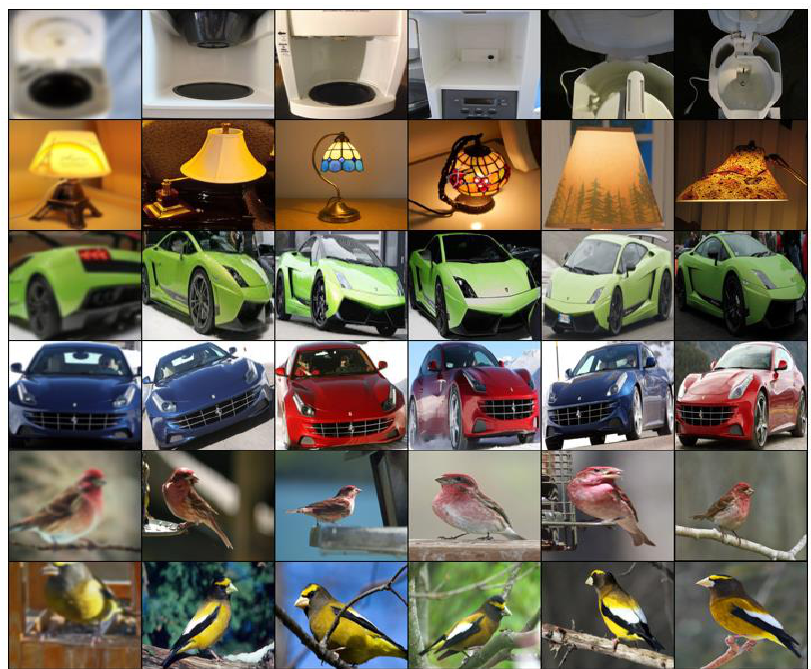
Figure 5. Top 5 retrieval results on mild resolution reduction samples. The first image in each row is the query image. The first two rows show samples from the SOP dataset, the next two rows show samples from the CARS196 dataset, and the last two rows show samples from the CUB200-2011 dataset.